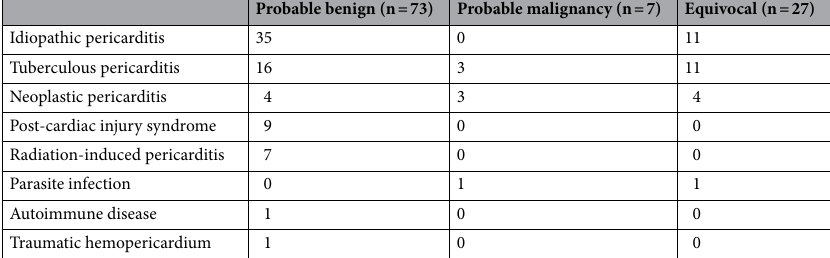
Table 4. PET/CT interpretation for the pericardial lesions and final